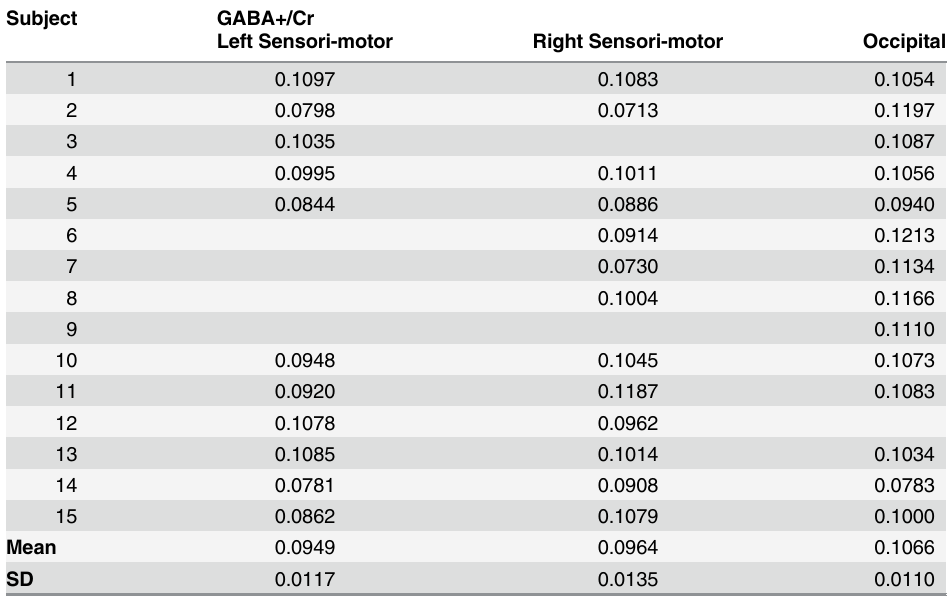
Table 1. GABA+/Cr values per MRS